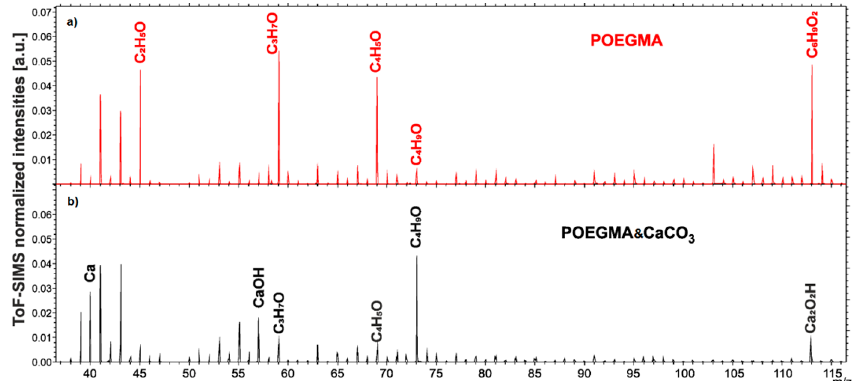
Figure 1. Representative positive ion time of flight secondary ion mass spectroscopy (ToF-SIMS) spectra of the POEGMA-grafted brush coatings ( a ) with embedded CaCO 3 NPs ( b ). The signals characteristic and unique for the coating following each fabrication step are marked with secondary ion names, respectively.